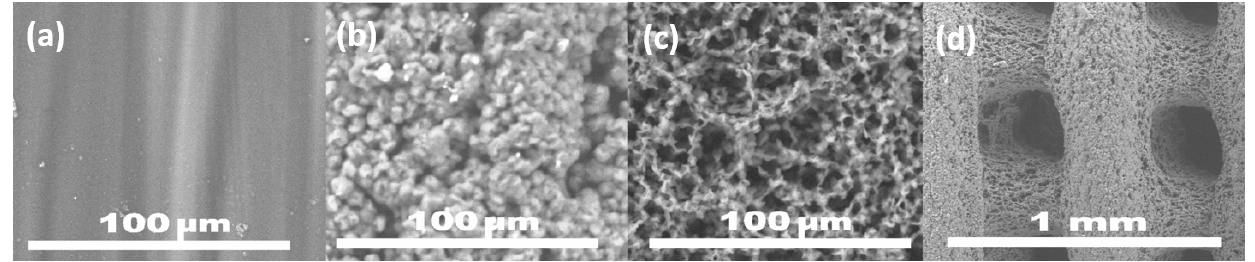
Figure 3. SEM images of a plain PLA surface ( a ) and after 1 and 8 min of immersion in acetone, ( b ) and ( c ), respectively. A woodpile structure after 1 m in acetone ( d